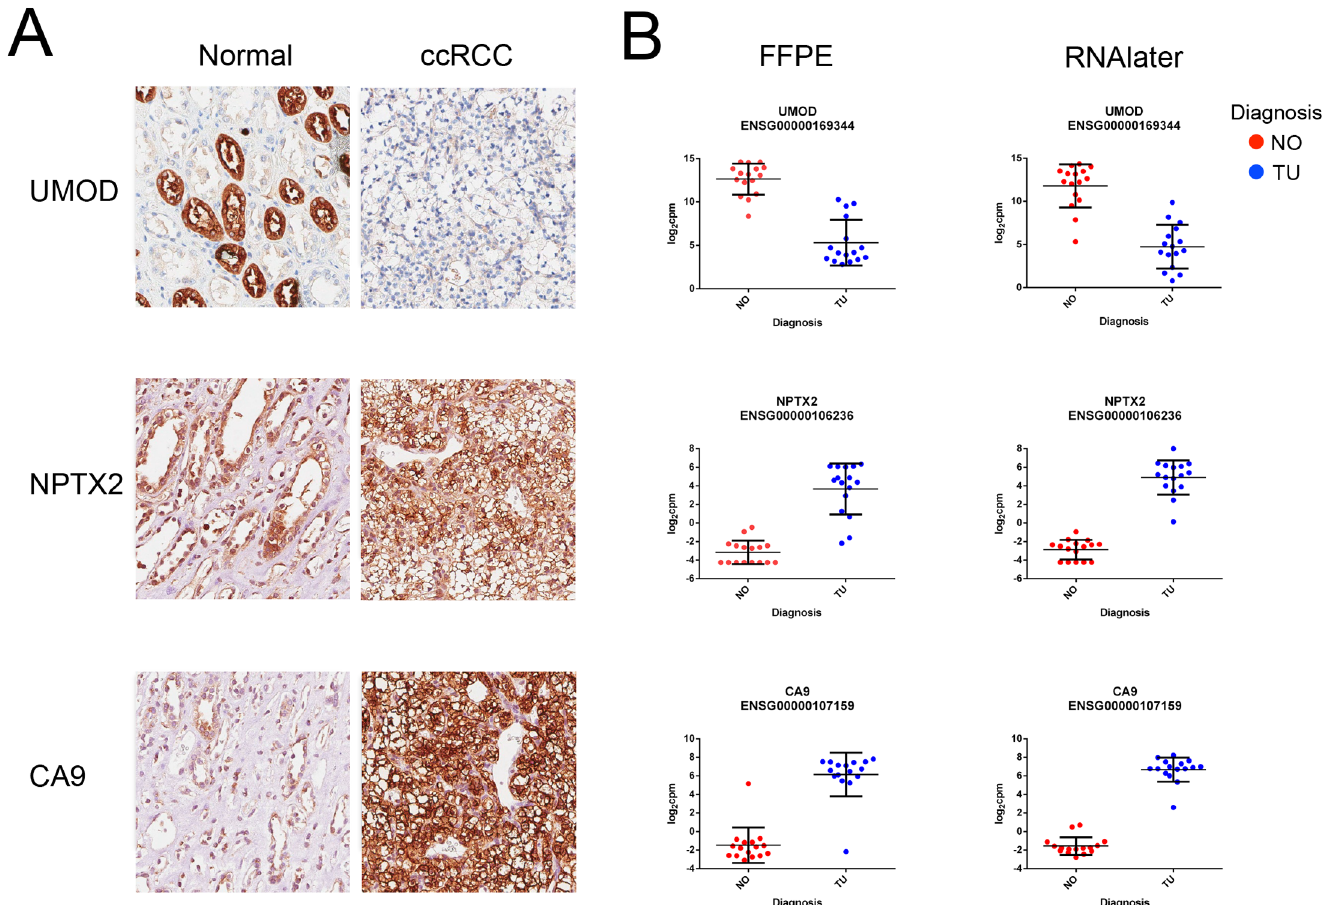
Fig 3. Immunohistochemistry and mRNA plots. (A) Immunohistochemistry of UMOD, NTPX2 and CA9. Magnification x20 , scale bar 50 μ m . (B) Respective mRNA abundance plots in the FFPE and in the RNAlater 1 datasets.